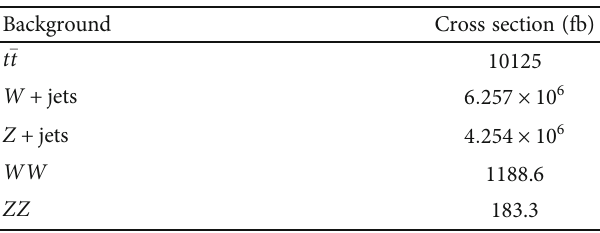
Table 2: List of backgrounds and their cross-sections to the